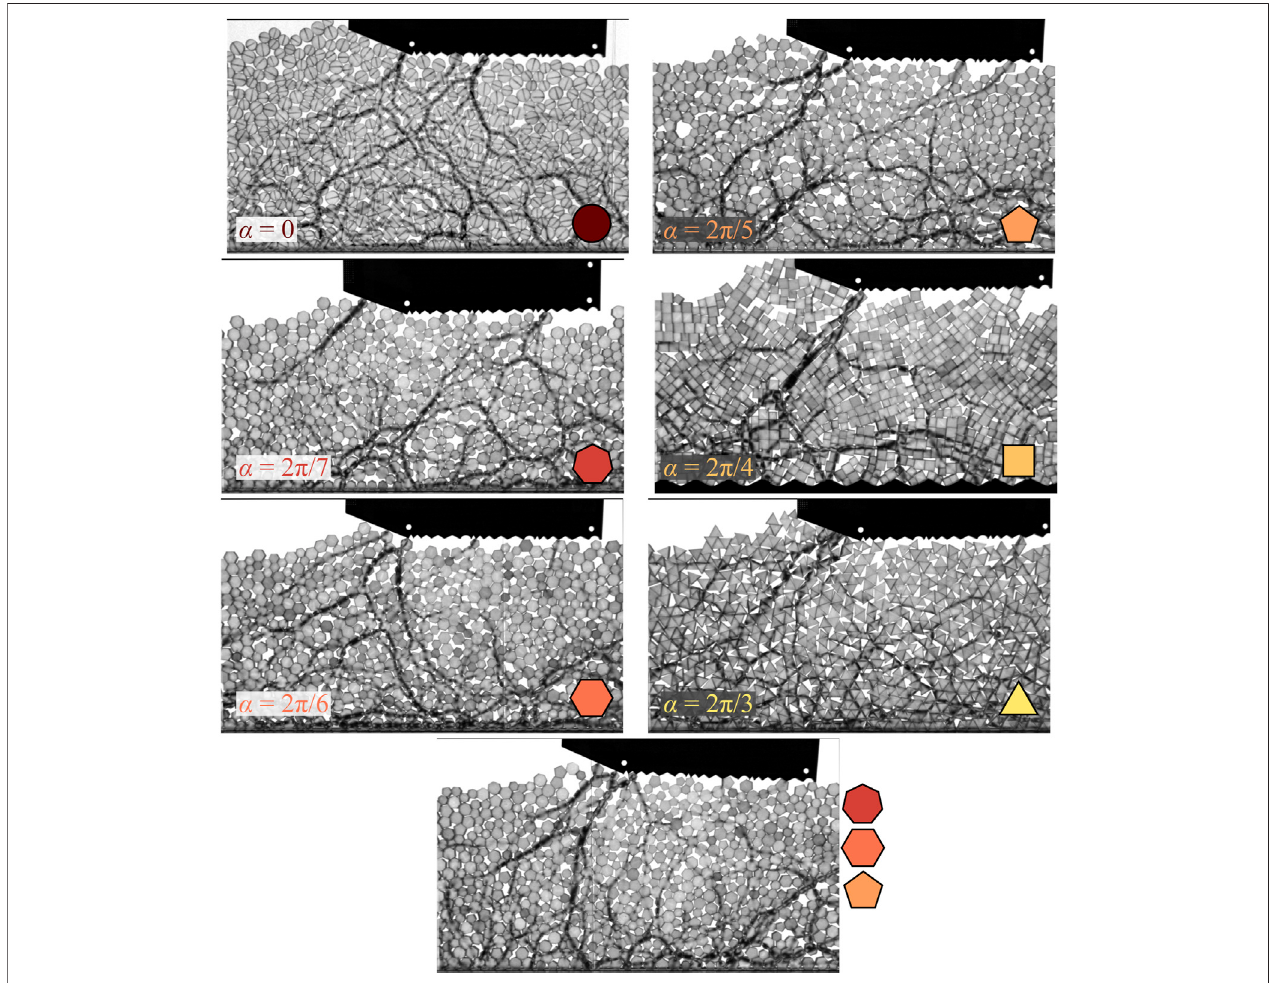
FIGURE 2 | Images obtained by subtracting polarized light from white light images, displaying both grains and grain stresses. Dark grains are experiencing signi fi cant forces from other grains and the slider.